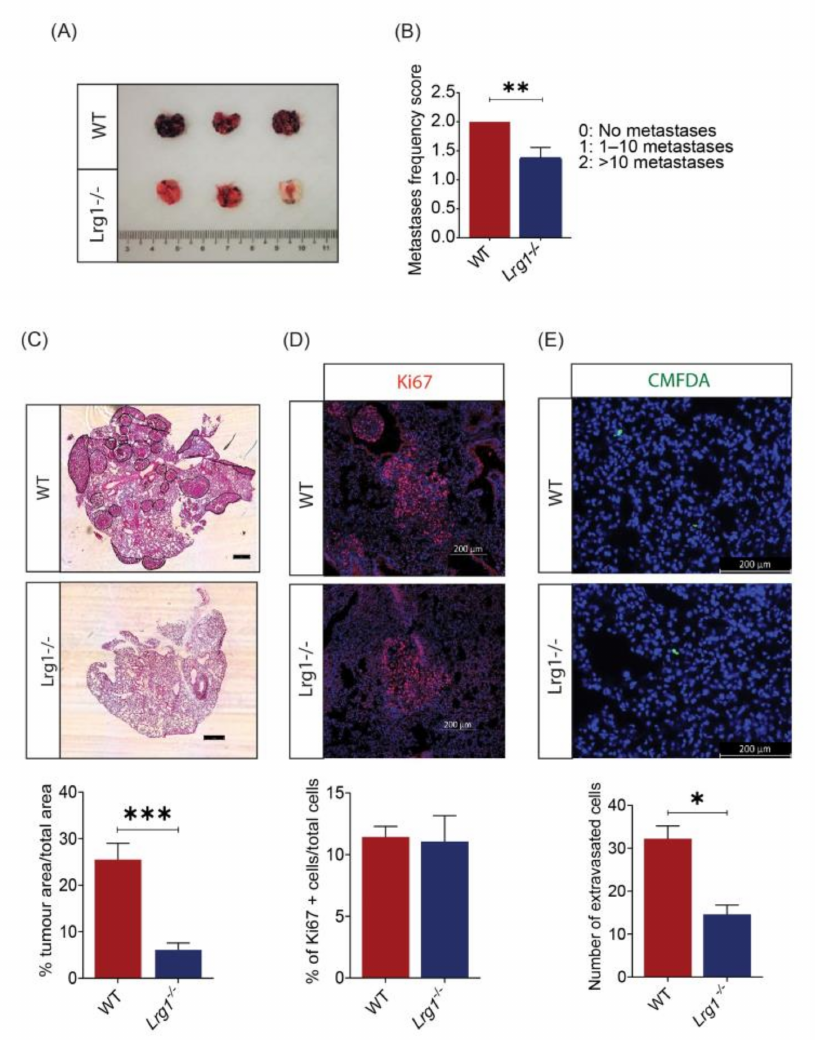
Figure 3. Host Lrg1 deficiency reduces pulmonary metastasis of melanoma in vivo. ( A ) Representa- tive images of lung metastases in wide-type and Lrg1 - / - mice. Nodules are easily identifiable due to their black pigmentation. ( B ) Quantification of lung metastases frequency in wide-type and Lrg1 - / - mice. ( C ) Representative images of haematoxylin-eosin staining (top) and quantification (below) of the metastatic burden of lung tissues in wide-type and Lrg1 - / - mice. The percentage of tumour nodule area over the total lung area was measured. ( D ) Representative images (top) and quantification (below) of Ki67+ cells (red) in lung tissues of wide-type and Lrg1 - / - mice. ( E ) Representative images of lung sections (top) to visualise extravasated melanoma cells identified via CMFDA Green signal (green) and quantification (below) of the number of extravasated cells out from blood vessel 24 h following intravenous injection of B16F10. Nuclei were labelled with DAPI (blue). Data are presented as the mean ± SEM. Statistical analysis was performed via two-tailed, unpaired Student’s t -test; * p < 0.05, ** p < 0.01; *** p < 0.001. Wildtype group: n = 9, Lrg1 - / - group: n =